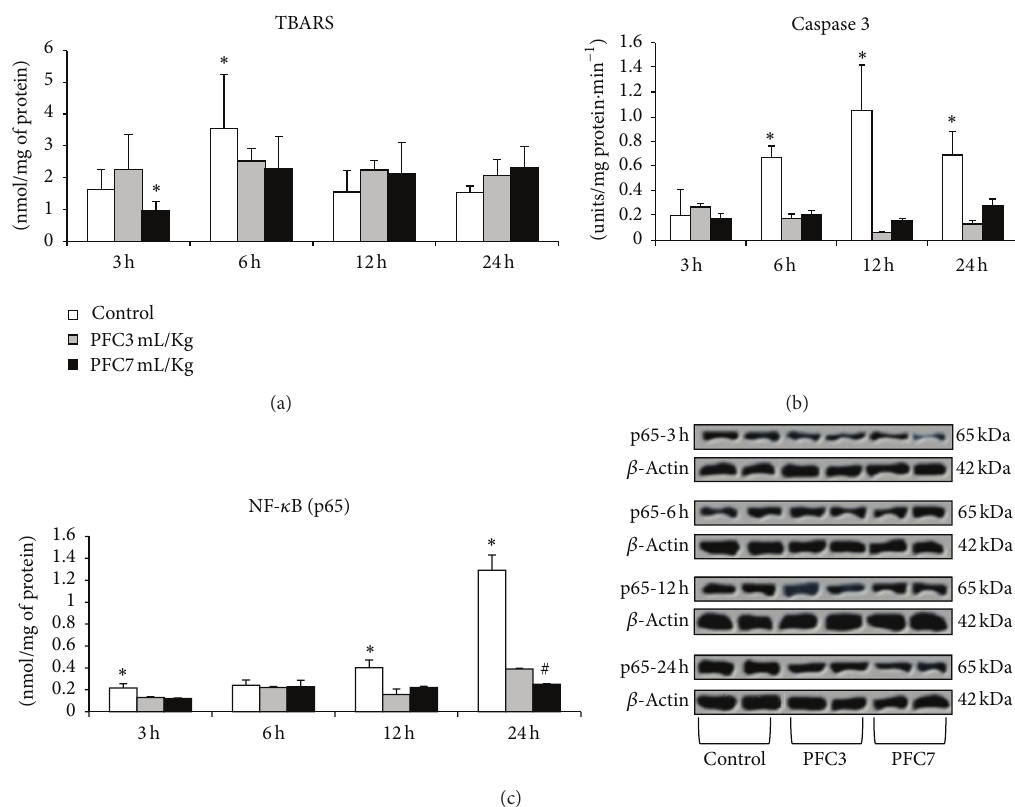
Figure 1: Apoptosis and inflammatory activity during lung preservation. (a) Effects of different periods of lung preservation on pulmonary lipid peroxidation. Using the TBARS assay, there was a significant decrease in lipid peroxidation at 3 hours of preservation in the PFC7 group ( ∗ 𝑃 > 0.05 ). The control group showed a significant increase in lipid peroxidation at 6h ( # 𝑃 > 0.05 ). Data are means ± standard deviation of the mean ( 𝑃 > 0.05 ). (b) Caspase 3 activity at different times of lung preservation. There is a significant increase in caspase 3 activity in the control group at 6, 12, and 24 hours ( ∗ 𝑃 < 0.001 ). Data are means ± SD of the mean. (c) NF- 𝜅 B expression (subunit p65) in the lung tissue at different times of lung preservation. A significant increase in the expression of p65 was observed in the control group at 3, 12, and 24 hours compared with the animals that used PFC ( ∗ 𝑃 < 0.05 ). PFC7 reduced the expression of p65 at 24 hours of preservation compared with PFC3 ( # 𝑃 < 0.05